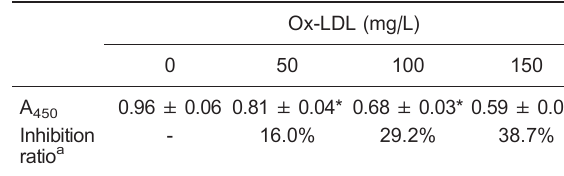
Figure 1. HUVEC shape by inverted microscopy. A , Control HUVECs showing normal adherent growth with a spindle or pentagonal shape. B , HUVECs incubated with Ox-LDL (150 m g/ mL) for 24 h. The cells are shrunken, with an increased rate of cell apoptosis indicated by an increased formation of apoptotic bodies. HUVECs: human umbilical vein endothelial cells; Ox- LDL: oxidative low-density lipoprotein.